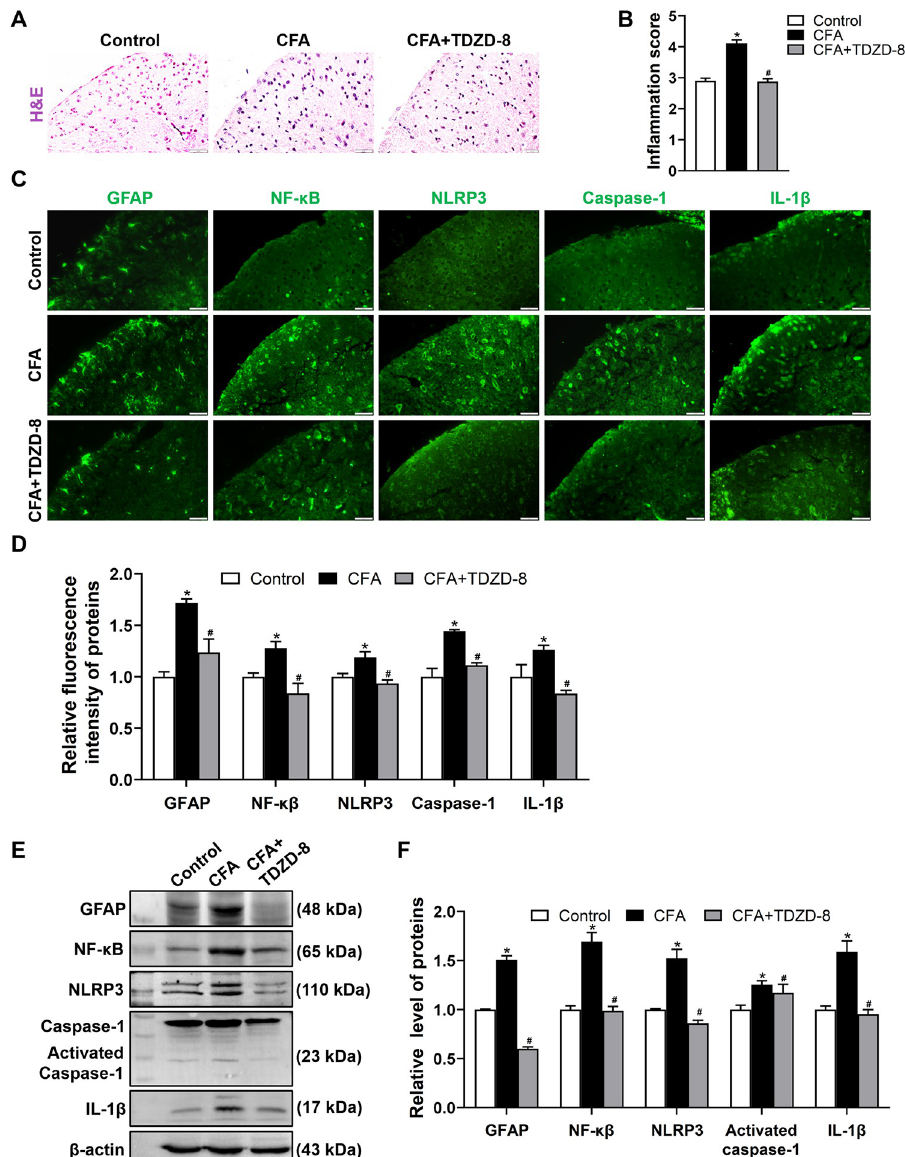
Fig 2. Effects of TDZD-8 treatment on spinal inflammatory infiltration and spinal GFAP, NF- κ B, NLRP3, caspase-1 protein levels. (A) Representative H&E staining images of spinal cord sections from control, CFA and CFA + TDZD-8 groups. The red arrows indicated inflammatory cells, scale bar = 20 μ m. (B) Quantitative analysis of inflammation score for the H&E staining in each group. (C, D) Representative immunofluorescence staining images of GFAP, NF- κ B, NLRP3, caspase-1, IL-1 β expressions in spinal dorsal horn (C) and quantitative fluorescence intensity analysis (D), scale bar = 20 μ m. (E, F) Western blot analysis (E) and quantification of the relative grey value (F) of GFAP, NF- κ B, NLRP3, caspase-1, IL-1 β expression level in spinal cord of control, CFA and CFA + TDZD-8 groups. Data are presented as mean ± SD (n = 3). * P < 0.05 vs . control group, # P < 0.05 vs . CFA group. https://doi.org/10.1371/journal.pone.0284332.g002 TDZD-8 reduces IL-1 β induced mitochondrial ROS levels in cells The changes of mitochondrial membrane potential (MMP) were detected by JC-1. Monomeric green form presents lower MMP, while red aggregates form presents higher MMP. IL-1 β stim- ulation in C6 cells induced lower MMP. TDZD-8 treatment restored MMP in IL-1 β +TDZD-8